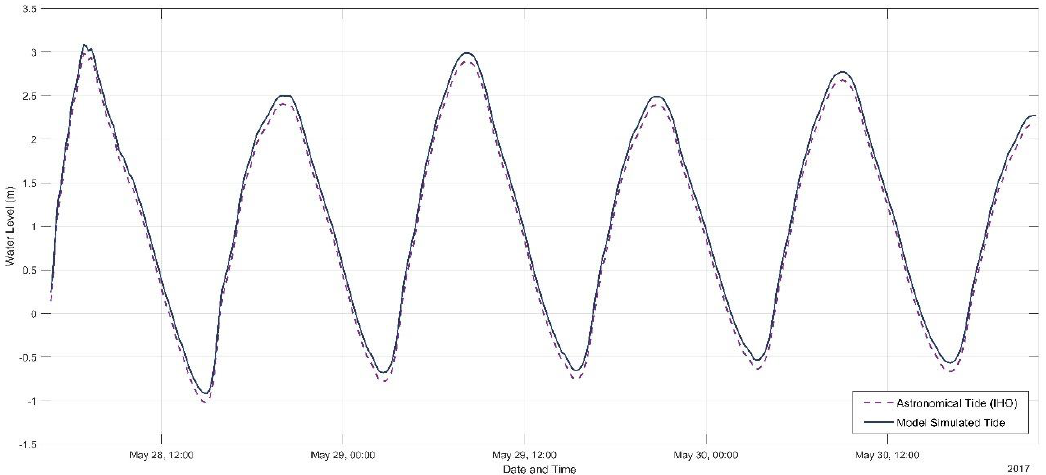
Figure 4. Comparison between model-simulated tide and astronomical tide predicted from a tide predictor. The R 2 value is 0.99.